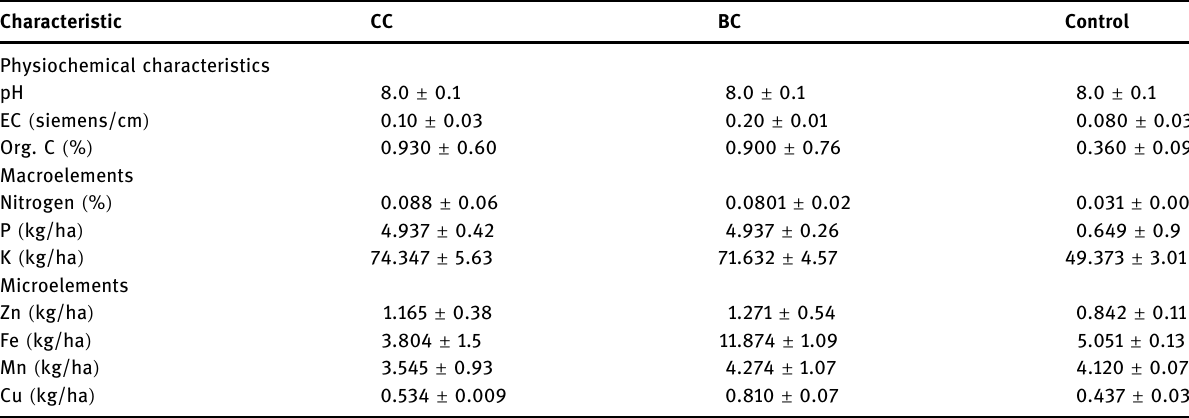
Table 5: Analysis of physiochemical, macro and micronutrients of rhizosphere soil samples